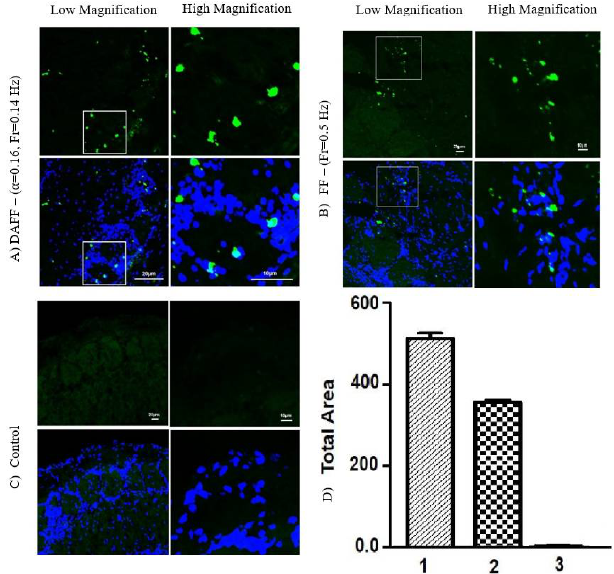
Figure 11. Confocal microscopy images of brain tissue samples: ( A ) DAFF ( t ) of 6 A, α = 0.16 and 0.144 Hz; ( B ) FF ( t ) of 6 A and 0.5 Hz [27]; ( C ) control; and ( D ) magnetic nanoparticle (MNP) accumulation. Data are the standard error of the mean ( ± SEM) of triplicate experiments ( n = 3): (1) DAFF ( t ) of 6 A, α = 0.16, and 0.144 Hz; (2) FF ( t ) of 6 A and 0.5 Hz; and (3)